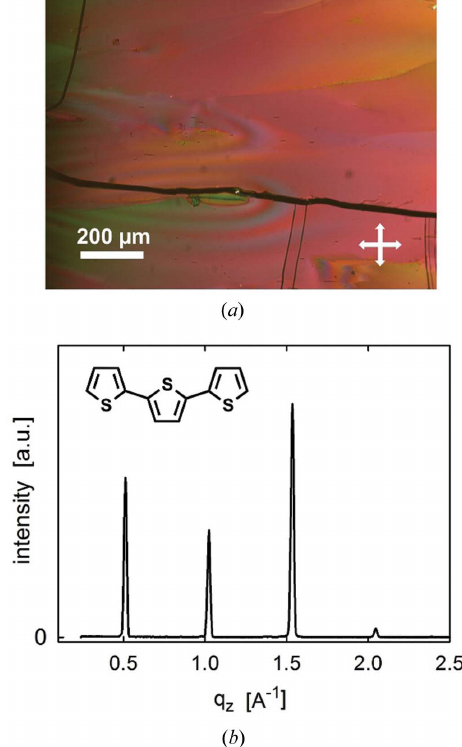
Figure 2 ( a ) Optical microscopy image using crossed polarizers and ( b ) specular X- ray diffraction pattern of terthiophene crystals prepared by thermal gradient crystallization on a glass substrate. The inset provides the chemical structure of the molecule